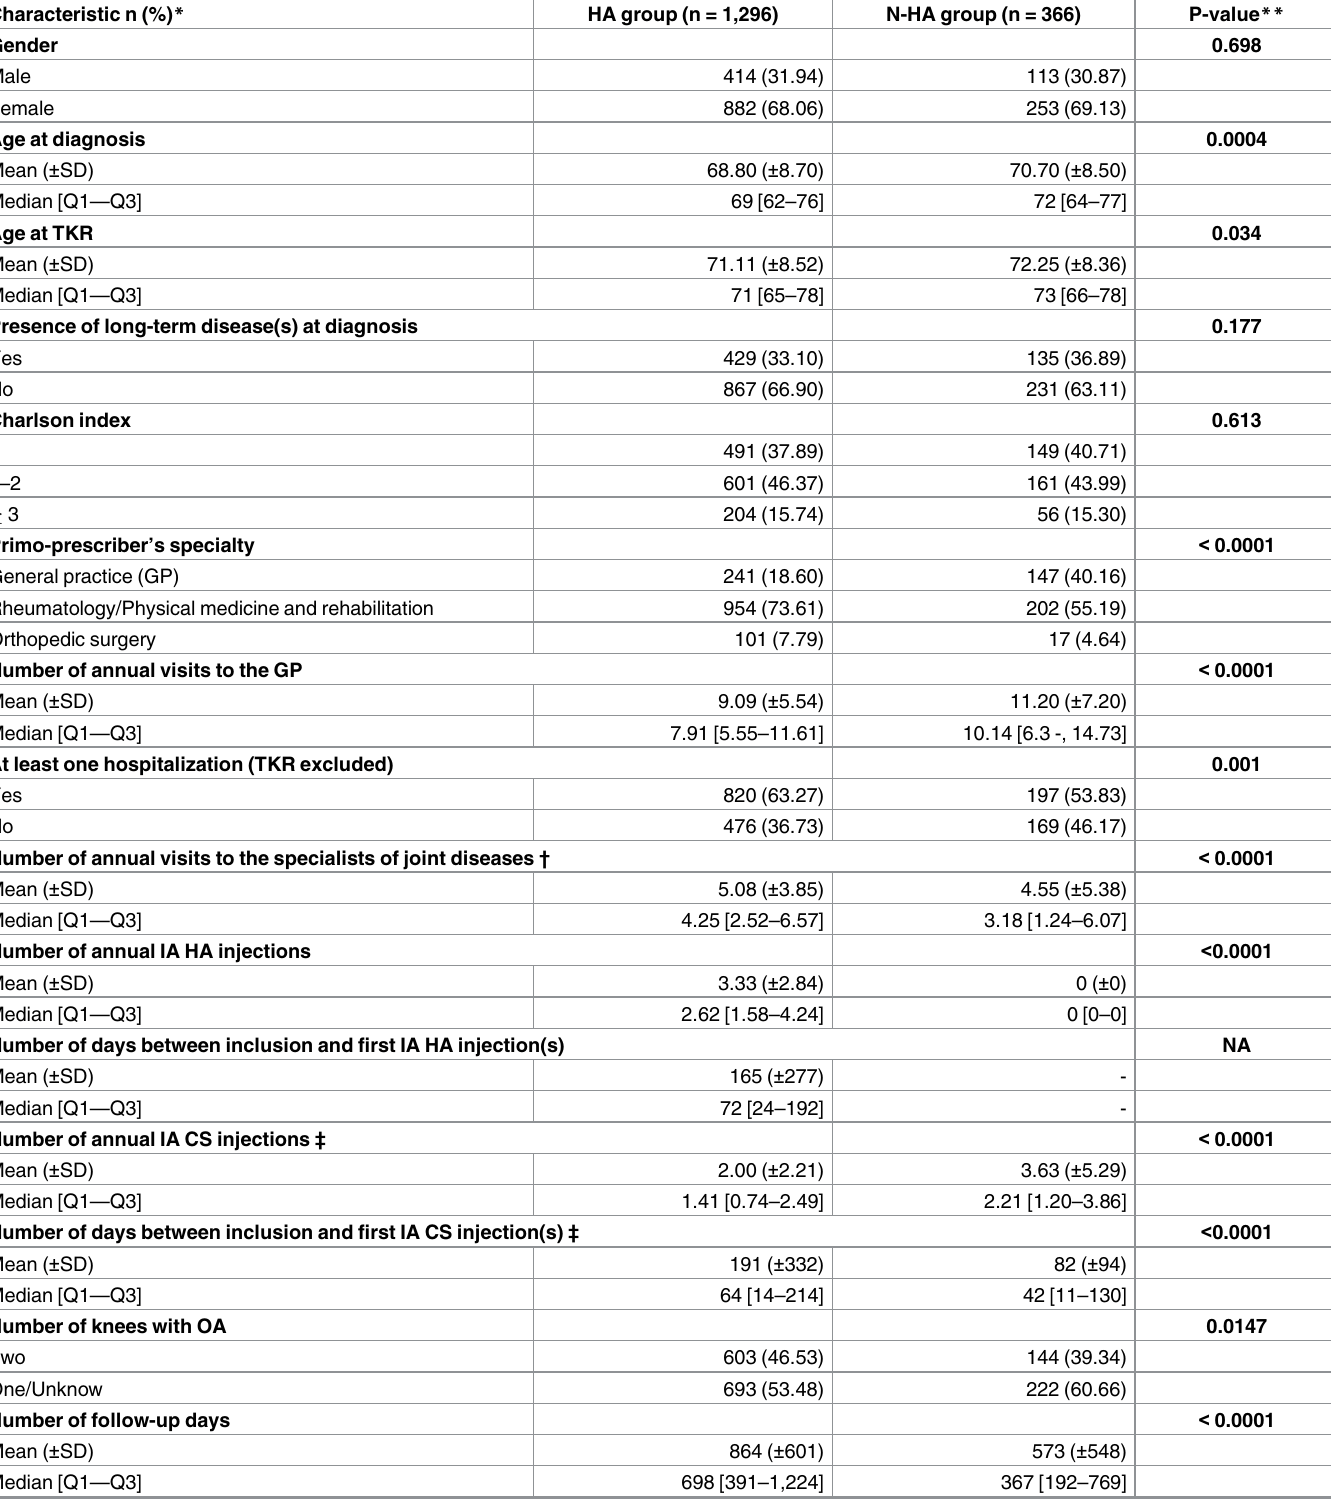
Table 2. Bivariate analysis of knee OA patients who had